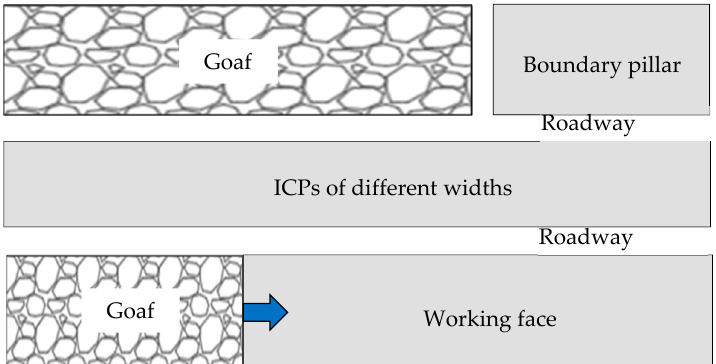
Figure 1. Layout diagram of isolated coal pillars (ICPs). A mining design using ICPs with different widths between neighboring working faces is preferred.